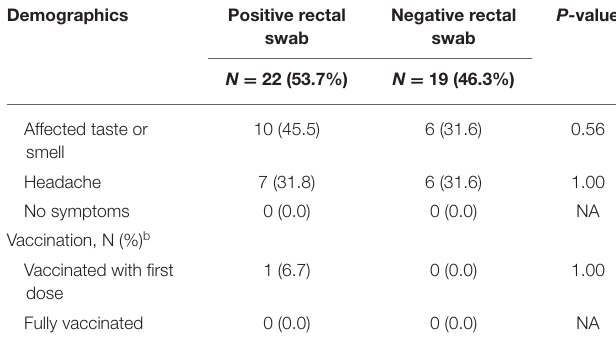
Demographics Positive rectal Negative rectal swab